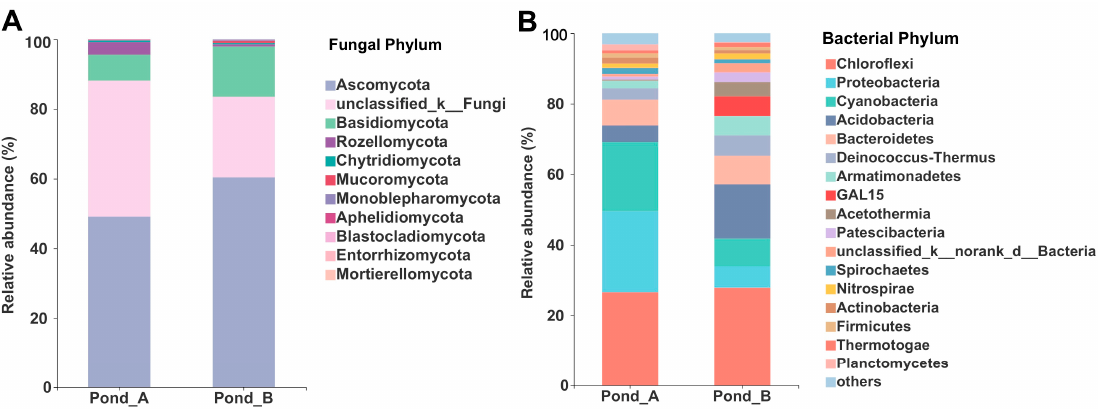
Figure 4. Phylum-level relative abundance of fungi ( A ) and bacteria ( B ) from the two analyzed ponds of the Julong hot springs. The bacterial phyla with very low relative abundances (<1%) were merged as “others” in the bar plot. In the taxa names, “d” = domain and “k” =